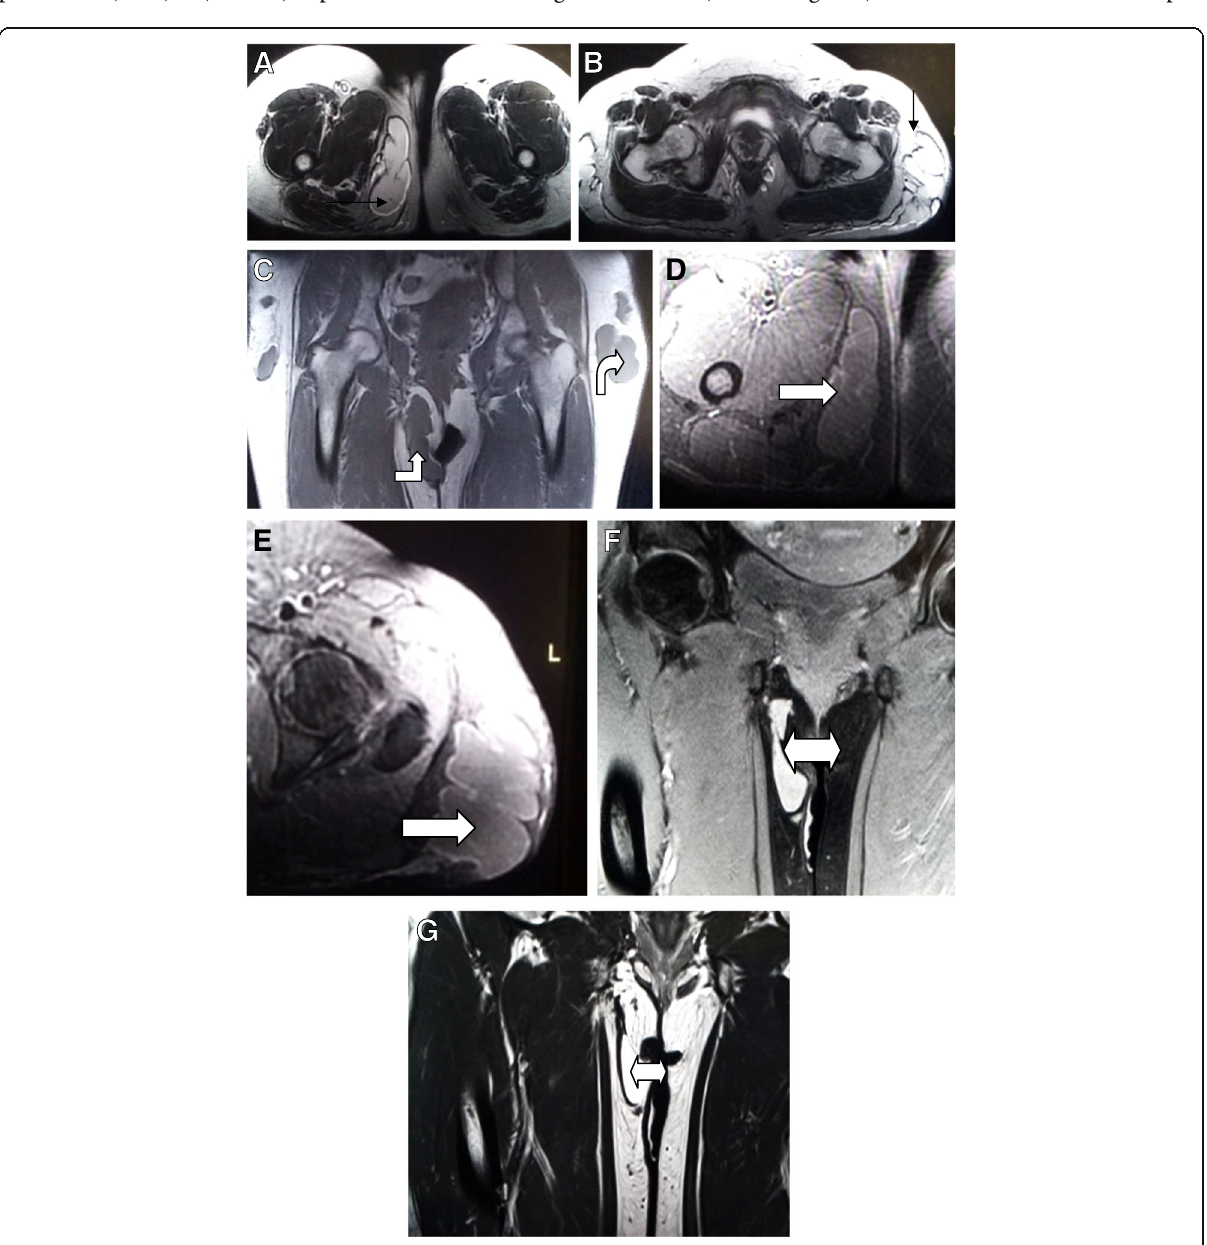
Fig. 4 A 40-year-old patient with history of right upper thigh swelling for investigation. a Axial T2WI at the level of the lesion ( a ) and above ( b ) at the level of gluteal injectables showing similar T2WI hyperintense signal intensity lesions (black arrow in a and b ). c Coronal T1WI showing similar hypointense signal intensity between the lesion in the medial aspect of the right thigh and the injectable fillers (curved open arrow). Axial T1WI post contrast sequence at the level of the lesion (open arrow in d ) and at the level of the injectable fillers ( e ) showing no enhancement with subtle rim enhancement. The diagnosis of filler migration to the right upper thigh was confirmed by surgical aspiration with marked decrease in the lesion size noted in the coronal T2WI Dixon water only sequence ( f ) and coronal T2WI ( g ) (double headed arrow in f and g